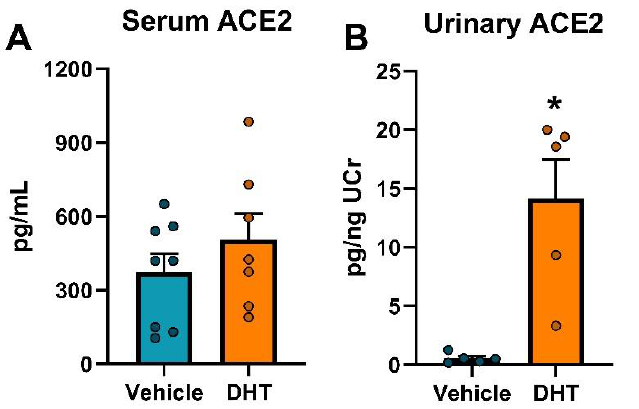
Figure 5. Serum and urinary ACE2 protein regulation by DHT. Serum ( A , n = 7–8/group) and urinary ACE2 ( B , n = 5/group) corrected by urinary creatinine. Data analyzed by t -test, with Welch’s correction for urinary ACE2. *: p < 0.05.